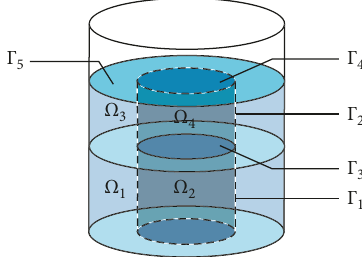
Figure 2: Subdomains and